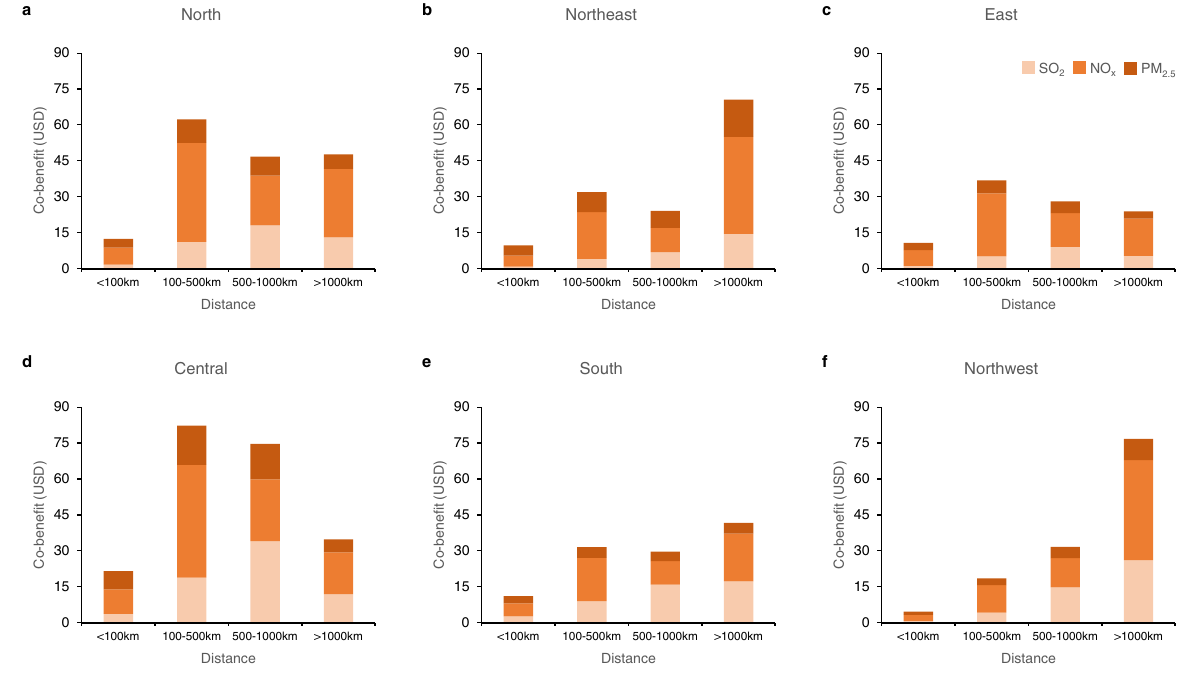
Fig. 5 The distribution of air pollutant-speci fi c co-bene fi ts in different ranges. The affected regions are divided into four ranges according to distance from power plants: within 100, 100 – 500, 500 – 1000, and more than 1000 km. a – f present the results in six regional power grids, respectively (unit is in USD per ton CO 2 emission